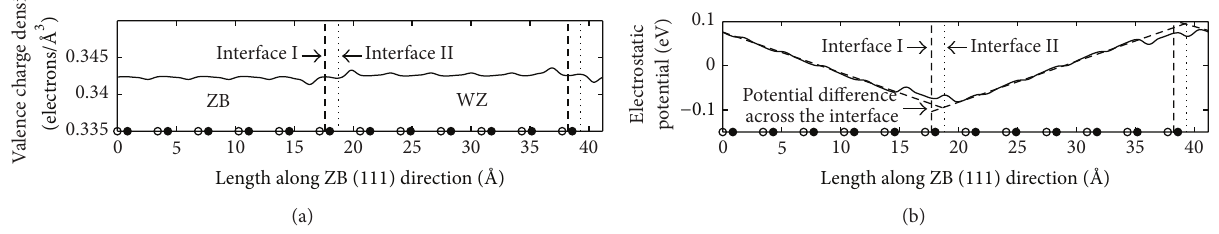
Figure 2: (a) Macroaveraged valence charge density and (b) macroaveraged electrostatic potential in CdS ZB/WZ heterocrystalline superlattice. For empty and solid circles and vertical dashed and dotted lines, please see Figure 1. Table 2: Band offset (VBO and CBO) at CdS ZB/WZ heterocrystalline interface (values in parentheses without considering the interface dipole) and band gap ( 𝐸 𝑔 ) with different zinc-blende (ZB) and wurtzite (WZ) atomic layers.